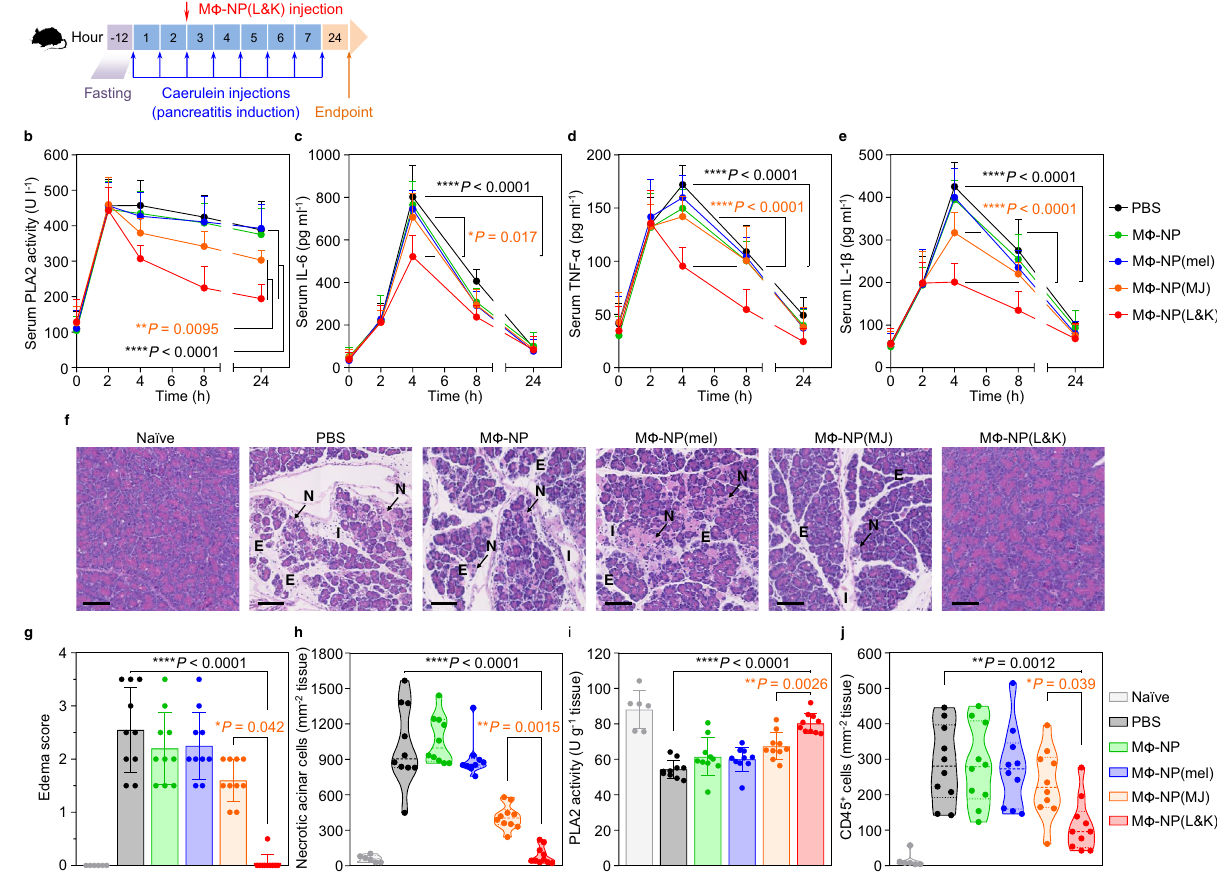
Fig. 4 Therapeutic ef fi cacy in a mouse model of mild acute pancreatitis. a The study protocol of pancreatitis induction and treatment with M Φ -NP(L&K). b PLA2 activity pro fi le in serum of CAE-AP mice treated with different nanoparticle formulations. Concentration pro fi les of key in fl ammatory cytokines, including IL-6 ( c ), TNF- α ( d ), and IL-1 β ( e ), in the serum of CAE-AP mice treated with different nanoparticle formulations. f Representative images of H&E staining on pancreas sections from CAE-AP mice collected 24 h after receiving the treatments. Scale bars, 100 μ m. N acinar necrosis, E edema, I cell in fi ltration. g Edema score of H&E-stained pancreas sections from CAE-AP mice after receiving different nanoparticle treatments. h Quanti fi cation of necrotic cells in the H&E-stained pancreas sections from CAE-AP mice receiving different nanoparticle treatments. i PLA2 activity in the pancreatic tissue of CAE-AP mice treated with different nanoparticle formulations. j Quanti fi cation of CD45 + cells in the anti-CD45-stained pancreas sections from CAE-AP mice receiving different nanoparticle treatments. For serum PLA2 and cytokine pro fi les, statistical analysis was performed using repeated-measure one- way ANOVA with Dunnett ’ s post hoc analysis. Statistical difference in edema scores was analyzed by Kruskal – Wallis non-parametric test with Dunnett ’ s post hoc analysis. Necrotic cell counts, tissue PLA2 activity, and CD45 + cell counts were analyzed by using one-way ANOVA with Dunnett ’ s post hoc analysis. Data presented as mean ± s.d. * P ≤ 0.05, ** P ≤ 0.01, *** P ≤ 0.001, **** P ≤ 0.0001. In all datasets, n = 10 mice treated with the same batch of M Φ